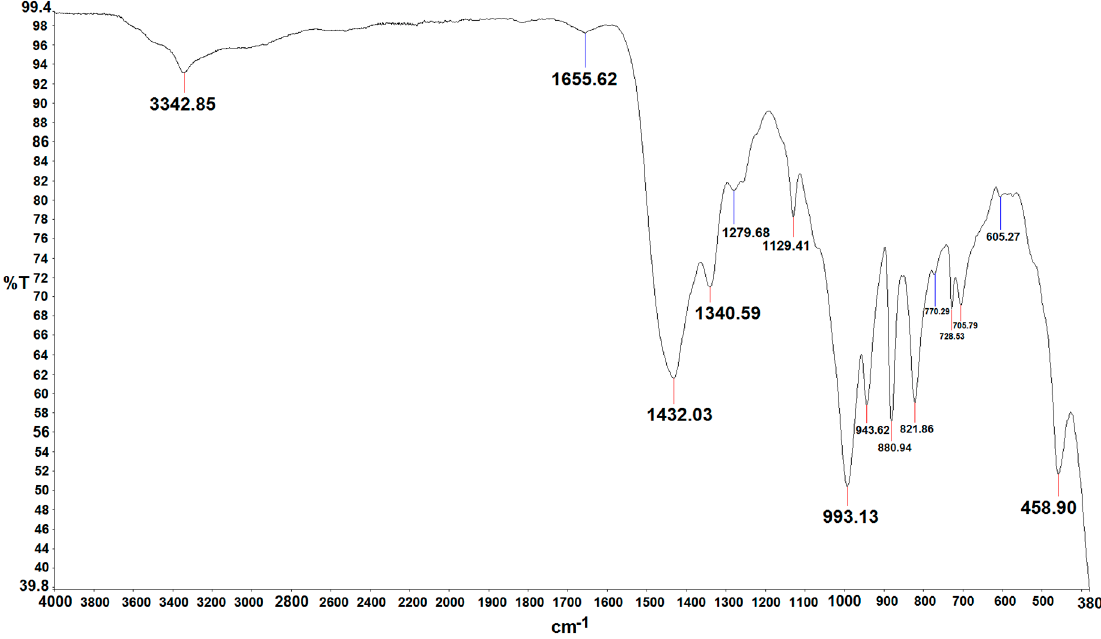
Figure 8. FTIR (Fourier Transform Infrared) spectra (made to illuminate the chemical structure of tincals) of solid phase tincal exhibited the infrared absorption bands (the bands at 728 cm − 1 and 880 cm − 1 show the characteristic peaks of tincal).